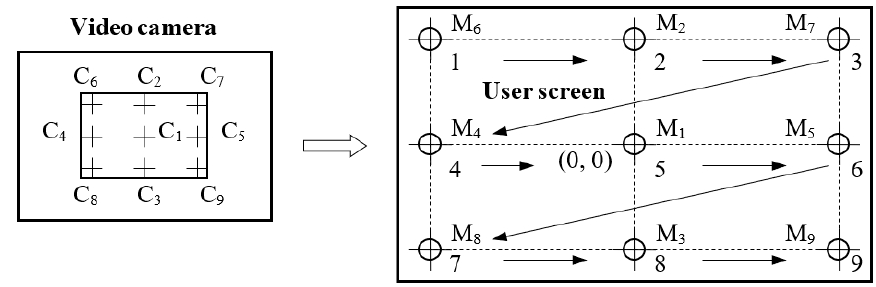
Figure 8. Calibration of the eye-tracking device.